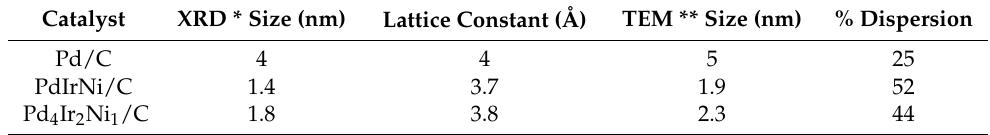
Table 2. Crystallographic and tomographic information of Pd/C, PdIrNi/C, and Pd 4 Ir 2 Ni 1 /C. Catalyst